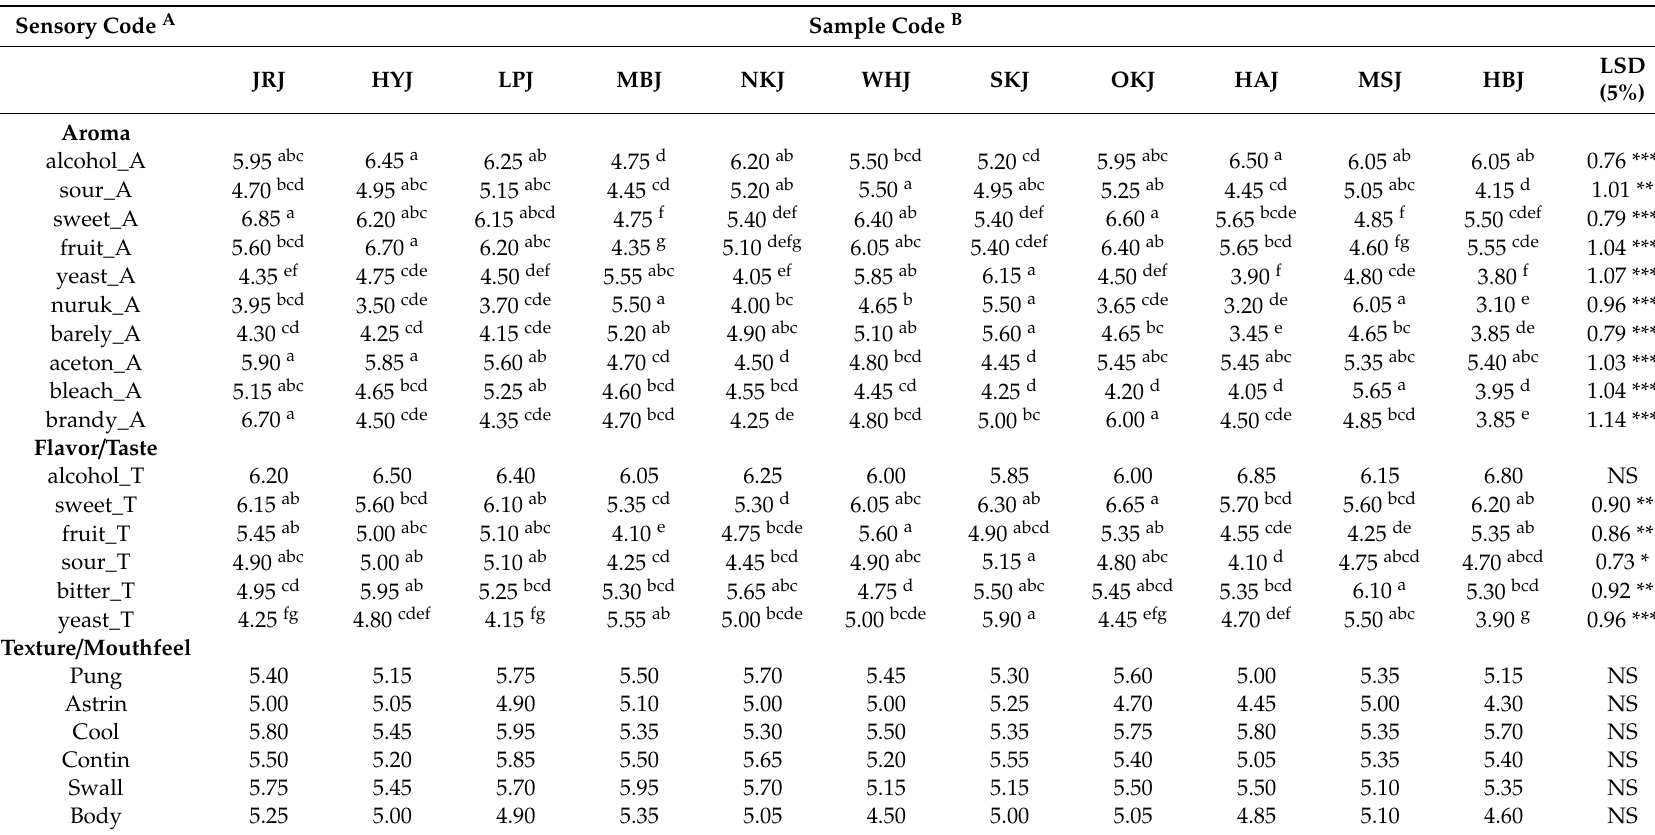
Table 4. Mean sensory intensity ratings for eleven distilled soju samples determined by descriptive analysis from a panel of ten judges over duplicate replications. Sensory Code